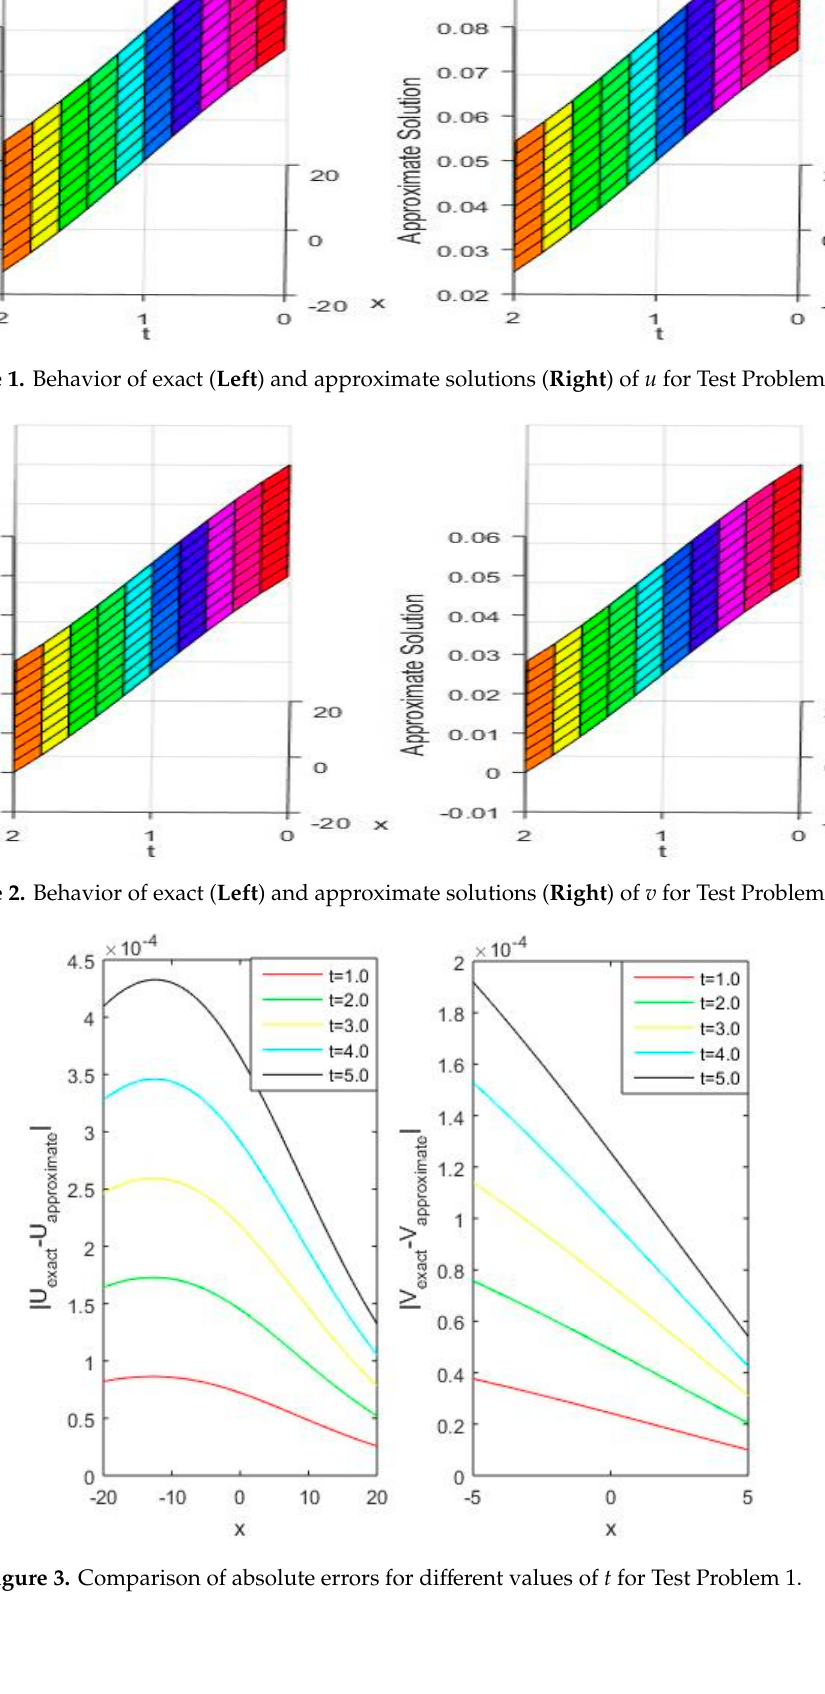
Figure 4. Approximation solution of u ( Left ) and approximation solution of v ( Right ) for different values of t . In Tables 1 and 2, the 𝐿 (cid:2870) and 𝐿 (cid:2998) error norms are given for our proposed algorithm MVIA-II, MVIA-I, and finite difference method (FDM), as well as the lattice Boltzmann model (LBM) for 𝑢 and 𝑣 , respectively, while Table 3 shows the comparison of errors of different methods for showing the accuracy of our proposed method. We can see that MVIA-II produces more accurate results than both FDM and LBM. The 𝐿 (cid:2870) and 𝐿 (cid:2998) error norms for different values of t are reported in Tables 2 and 3, which show that the proposed method gives more accurate results than the previous methods that have been used before. Figures 1 and 2 display the behavior of exact and numerical solutions for 𝑢 and 𝑣 by MVIA-II. Figure 3 presents the absolute error graphs for different values of 𝑡 for 𝑢 and 𝑣 , while Figure 4 is devoted to a plot solution at different time levels computed by MVIA-II. It can be seen that the method is uniformly convergent and gives accurate results. It is clear from the figures and tables that the proposed method can handle the coupled Burgers’ equations very accurately.